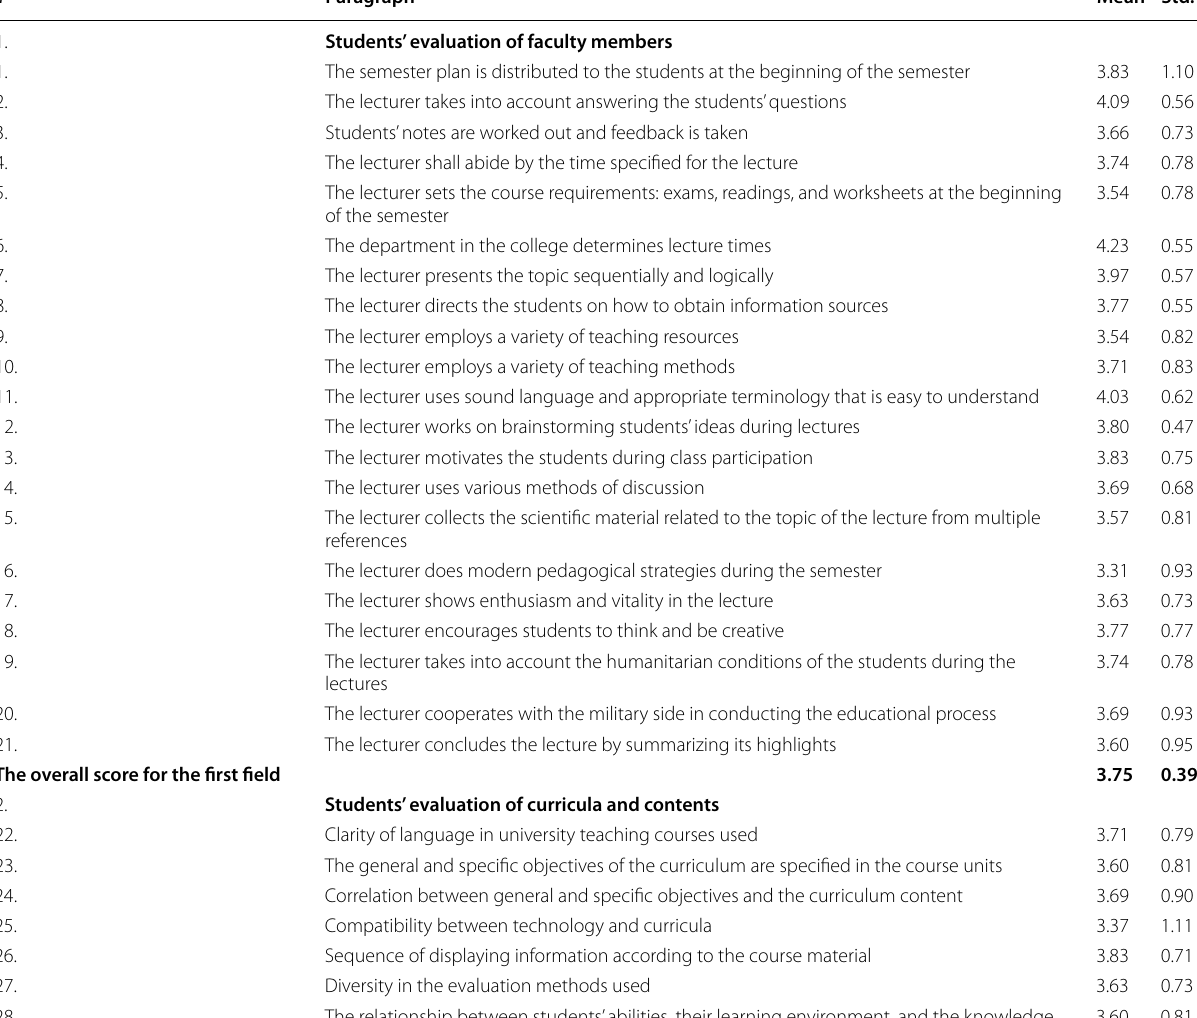
Table 2 Descriptive statistical analysis of students’ evaluation of the FS program at the Al-Istiqlal